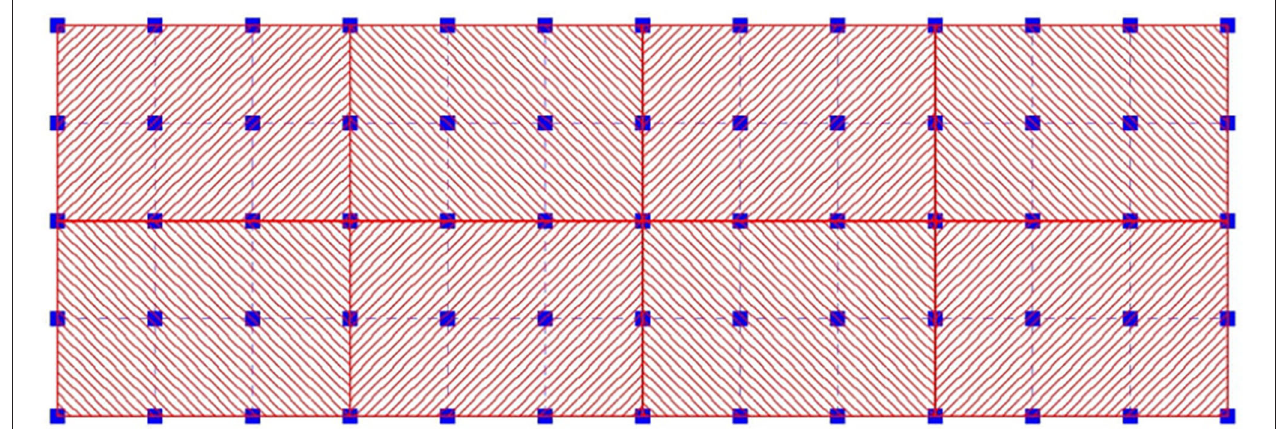
FIGURE 1 | Overlapping of a 2D voxel grid (red) with respect to the 2D computational grid (blue) for g v = 4 × 3 =